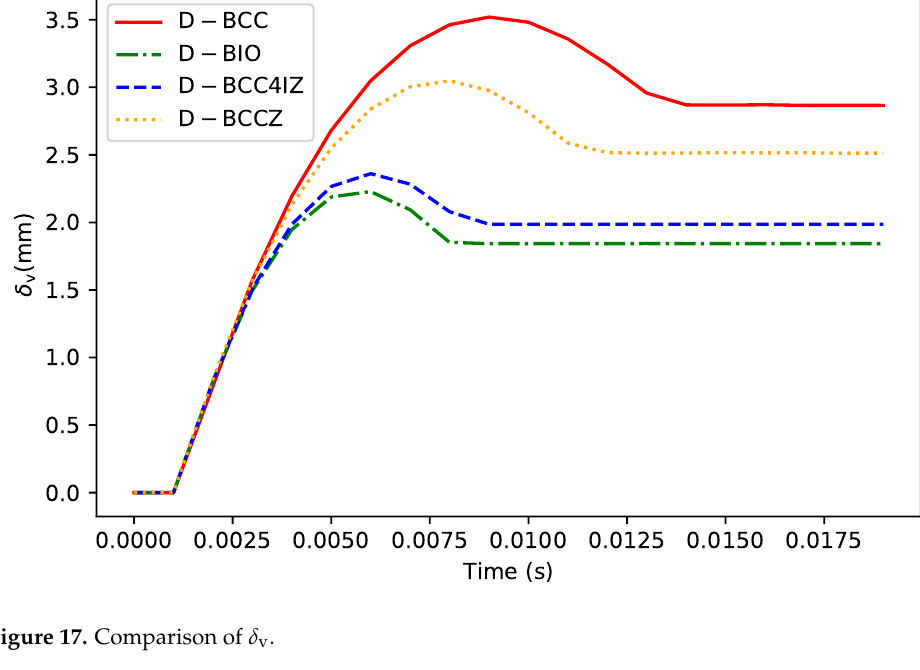
Figure 17. Comparison of δ v .